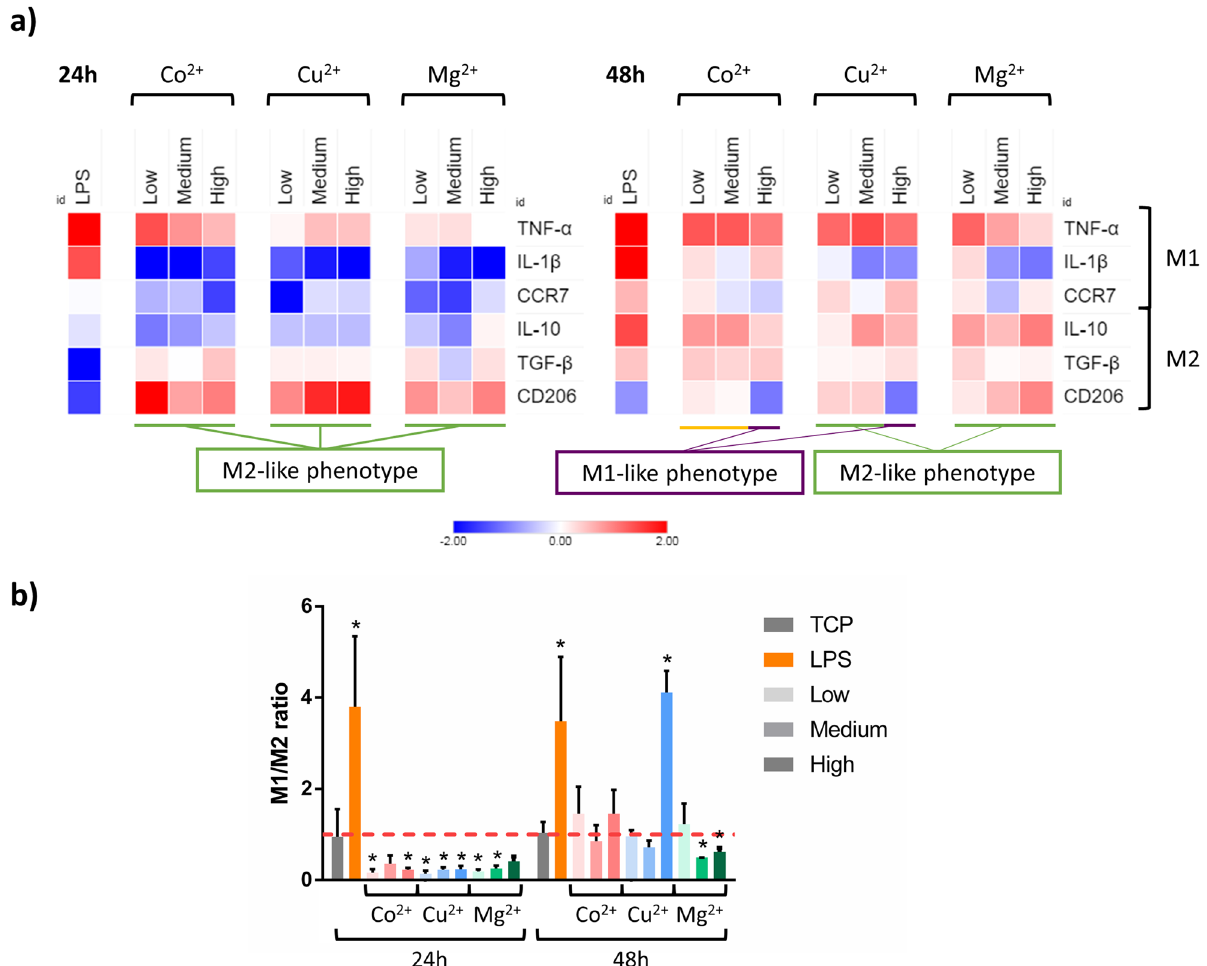
Figure 3. Effect of increasing concentrations of cobalt, copper and magnesium on the expression of M1 and M2 markers in THP-1 macrophage cell line. ( a ) After 24 or 48 h of incubation, the mRNA levels of three M1 markers (TNF-α, IL-1β and CCR7) and three M2 markers (IL-10, TGF-β and CD206) were determined by RT-qPCR. The purple line indicates those conditions that induce a M1-like phenotype, while the green line indicates those that induce a M2-like phenotype. Those conditions that induced a phenotype that should be further confirmed are indicated by the yellow line. ( b ) M1/M2 ratio was calculated from the gene expression of CCR7 and CD206 markers. A higher intensity of the color indicates a higher concentration of the ion. The results of the M1/M2 ratio for each condition were compared to the TCP of each day. Statistically significant differences ( p < 0.05) were represented with *. Statistical analysis of qRT-PCR results is in Supplementary Tables S1 and